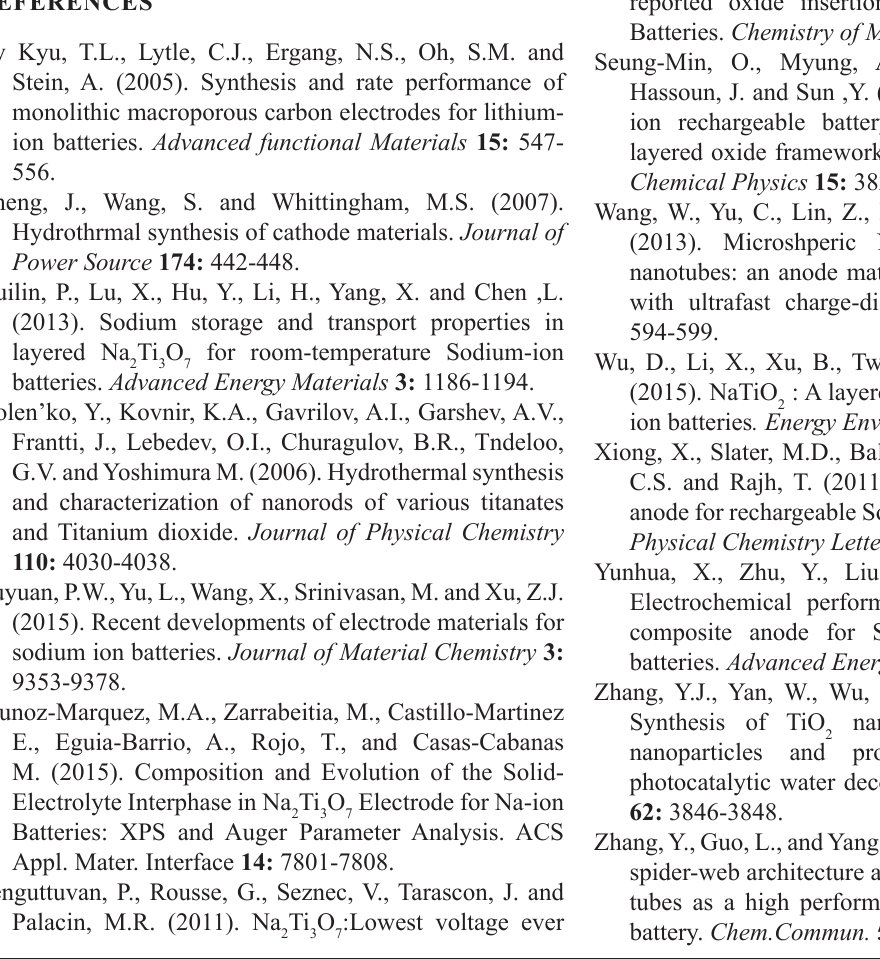
Ti O nanofibers. (a) The charge-discharge capacity versus cycle number at a current 2 3 7 Ti O at 0.05 mVs -1 in the voltage range 0.0-2.5 2 3 7